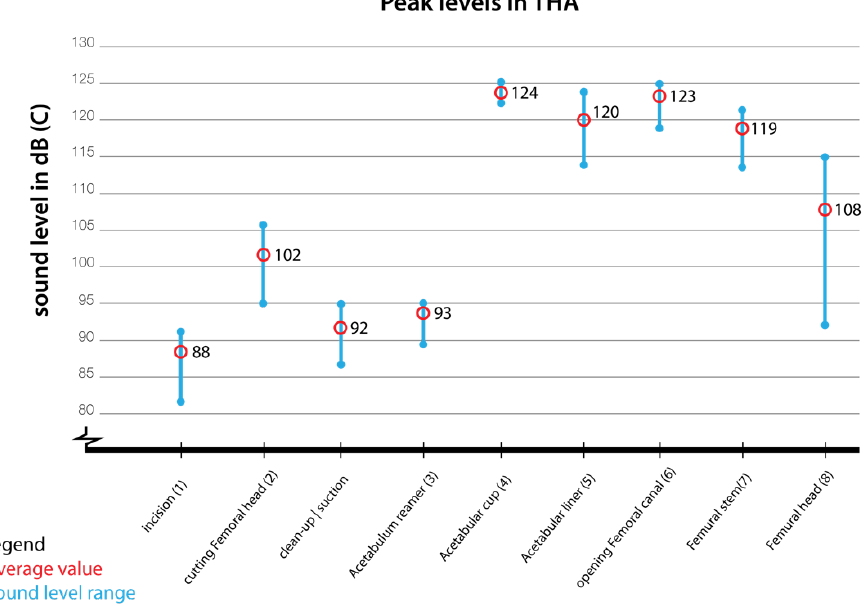
Figure 6. Peak dB(C) — LCpk measurements for (powered) surgical tools. Refer to Figure 5 to see the actions causing the sound.